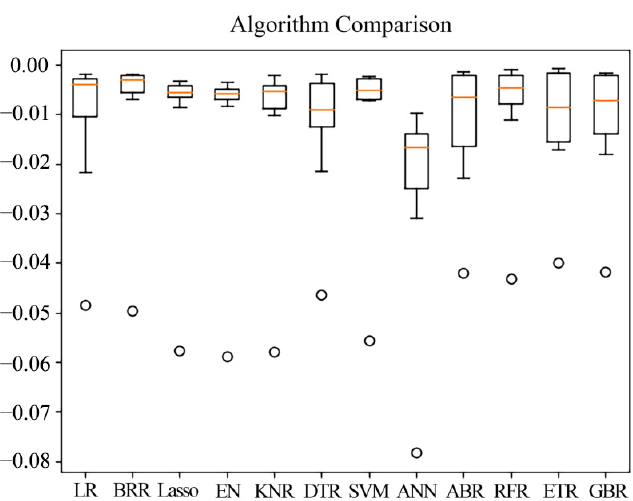
Figure 5. Box diagram of MSE regression loss for the algorithm comparison.